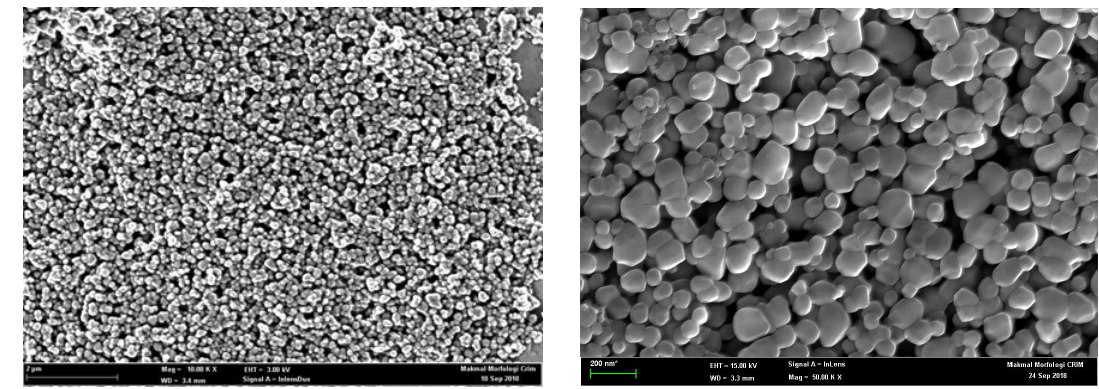
Figure 6. Field Emission Scanning Electron Microscopy (FESEM) micrographs of the surface coated aluminum plates: ( a ) uncoated surface; ( b ) 0.1 M TiO 2 coat; ( c ) 0.5 M TiO 2 coat; and ( d ) 1.0 M TiO 2 coat.